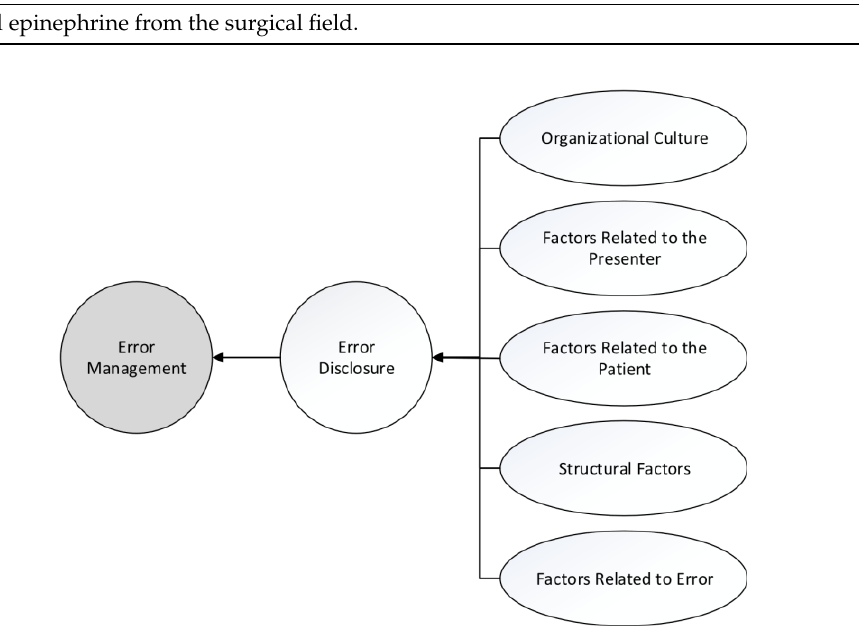
Figure 7. Managing errors and the factors and indexes comprising it [63].